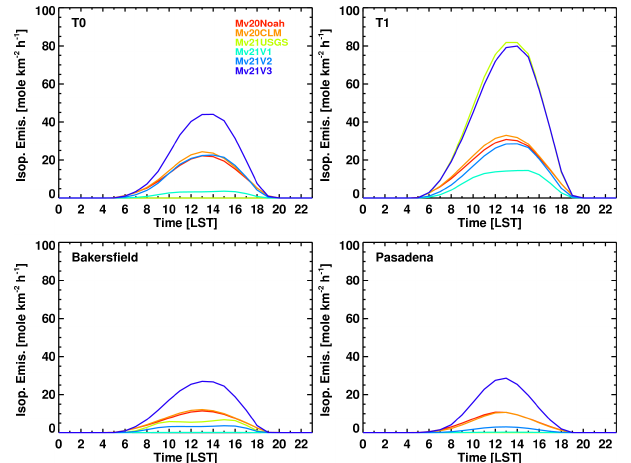
Figure 12. (a) Spatial distributions of monthly averaged surface iso- prene mixing ratios around the CARES T0 and T1 observational sites from the six simulations as listed in Table 1. The black lines parallel to the Sierra Nevada divide the region to the southwest and the northeast for comparison with CARES G-1 aircraft measure- ments shown in Figs. 16 and 17. (b) Same as panel (a) except around the CalNex observational sites Bakersfield and Pasadena. The black lines divide the region to southern California and the Central Valley for comparison with CalNex WP-3D aircraft measurements shown in Figs. 16 and 17.